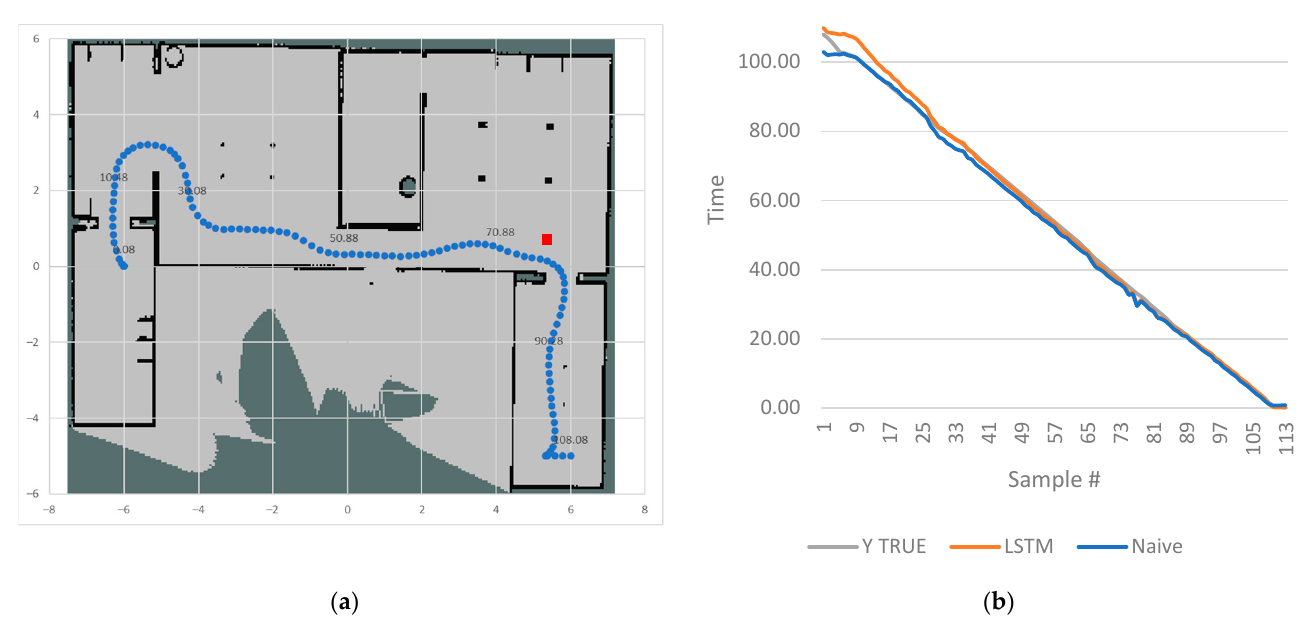
Figure 15. The path is clear. ( a ) Trajectory on map. Red square marks the position of the obstacle. ( b ) Time samples and estimates of travel time.